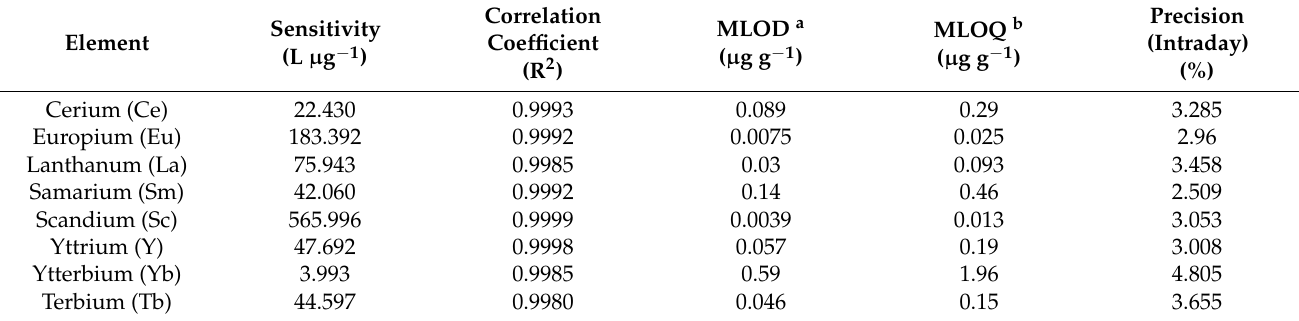
Table 4. Analytical figures of merits of the MAA-UAE for REEs in SARM 19. UAE conditions: [HNO 3 ] (1 mol L − 1 ), sample